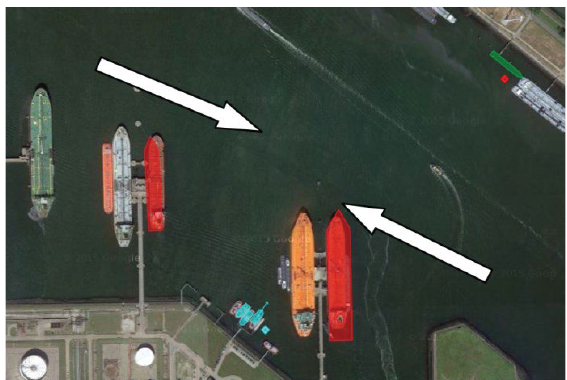
Fig. 1. Jetties for the oil terminal at the Port of Hamburg and directions of tidal currents